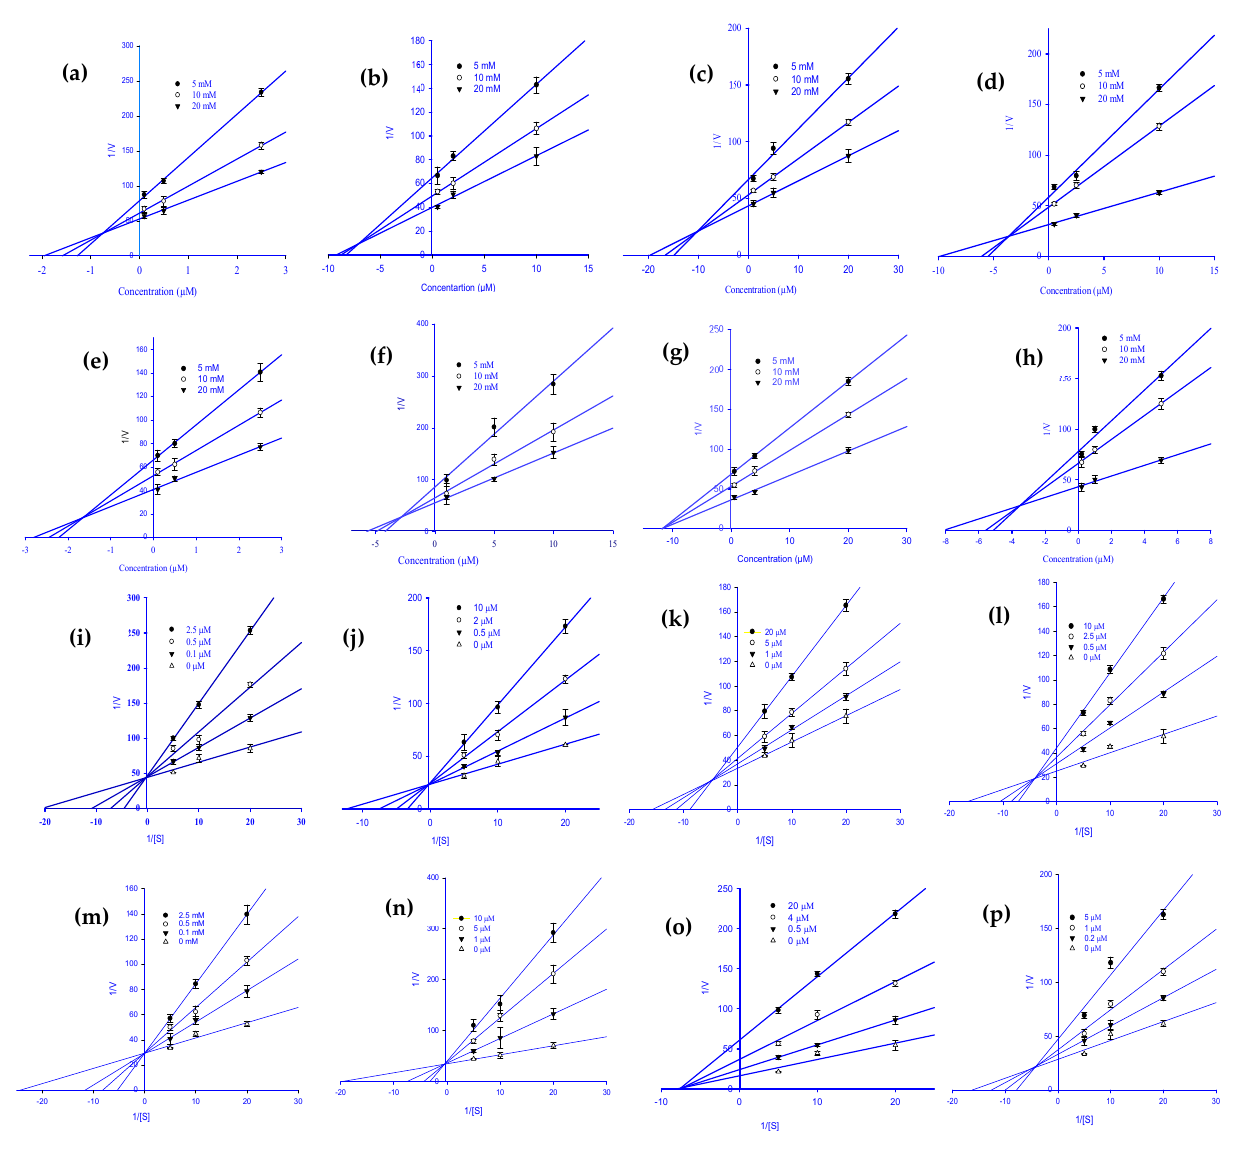
Figure 3. Dixon plots for HRAR inhibition by various ginsenoside derivatives. Protopanaxadiol ( a ), (20 S ) ginsenoside Rg3 ( b ), (20 R ) ginsenoside Rg3 ( c ), ginsenoside Rh2 ( d ), compound K ( e ), protopanaxatriol ( f ), (20 R ) ginsenoside Rg2 ( g ), and ginsenoside Rh1 ( h ) were tested in the presence of 5 mM (●), 10 mM ( ○ ), and 20 mM ( ▼ ) substrate ( DL -glyceraldehyde). Lineweaver–Burk plots for HRAR inhibition were analyzed in the presence of the following ginsenoside concentrations: 0 µM (Δ), 0.1 µM ( ▼ ), 0.5 µM ( ○ ), and 2.5 µM (●) for protopanaxadiol ( i ); 0 µM (Δ), 0.5 µM ( ▼ ), 2 µM ( ○ ), and 10 µM (●) for (20 S ) ginsenoside Rg3 ( j ); 0 µM (Δ), 1 µM ( ▼ ), 5 µM ( ○ ), and 20 µM (●) for (20 R ) ginsenoside Rg3 ( k ); 0 µM (Δ), 0.5 µM ( ▼ ), 2.5 µM ( ○ ), and 10 µM (●) for ginsenoside Rh2 ( l ); 0 µM (Δ), 0.1 µM ( ▼ ), 0.5 µM ( ○ ), and 2.5 µM (●) for compound K ( m ); 0 µM (Δ), 1 µM ( ▼ ), 5 µM ( ○ ), and 10 µM (●) for protopanaxatriol ( n ); 0 µM (Δ), 0.5 µM ( ▼ ), 4 µM ( ○ ), and 20 µM (●) for (20R) ginsenoside Rg2 ( o ); 0 µM (Δ), 0.2 µM ( ▼ ), 1 µM ( ○ ); and 5 µM (●) for ginsenoside Rh1 ( p ).